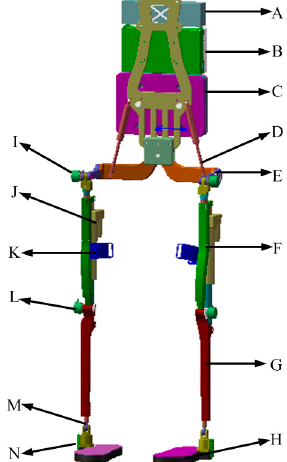
Figure 1. Mechanical structure of the exoskeleton. A : battery power source; B : control system enclosure; C : carried load; D : springs connecting the backpack with the waist part; E : waist part; F : thigh segment; G : shank segment; H : wearable shoes which have pressure sensors; I : optical encoder on the hip joint; J : actuation system consisting of DC motor, gear ratio and screw; K : connection cuff interacting with human limbs; L : optical encoder on knee joint; M : ankle joint; N : signal transfer for foot pressure.